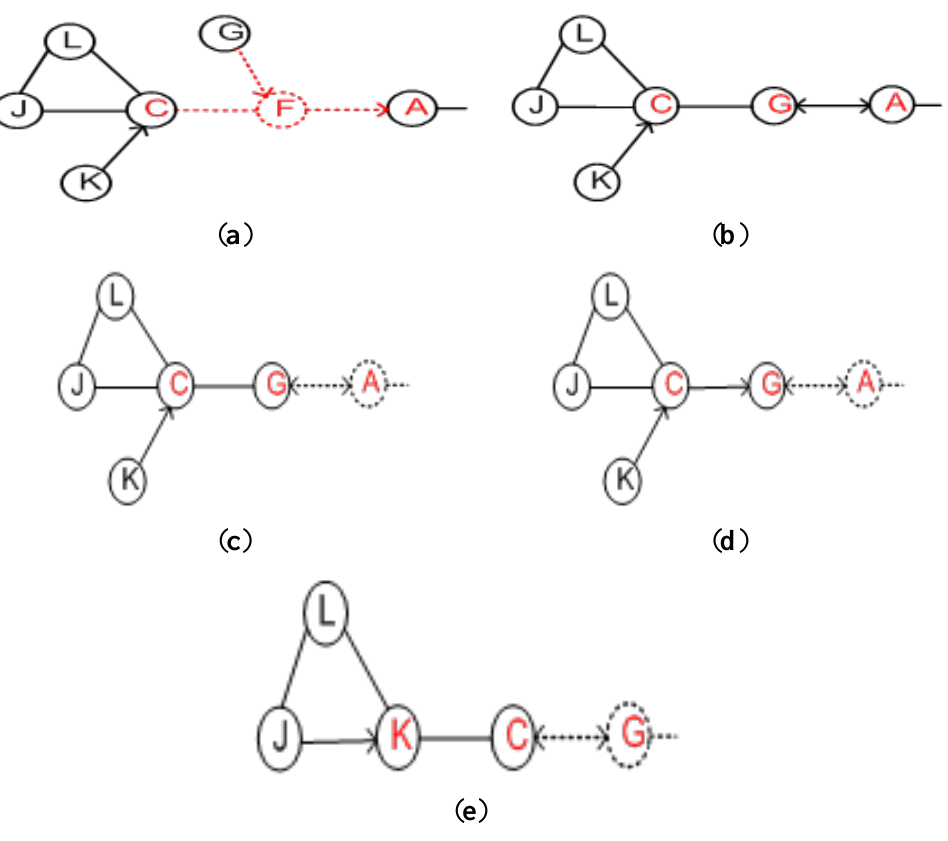
Figure 5. Applying the recovery process of